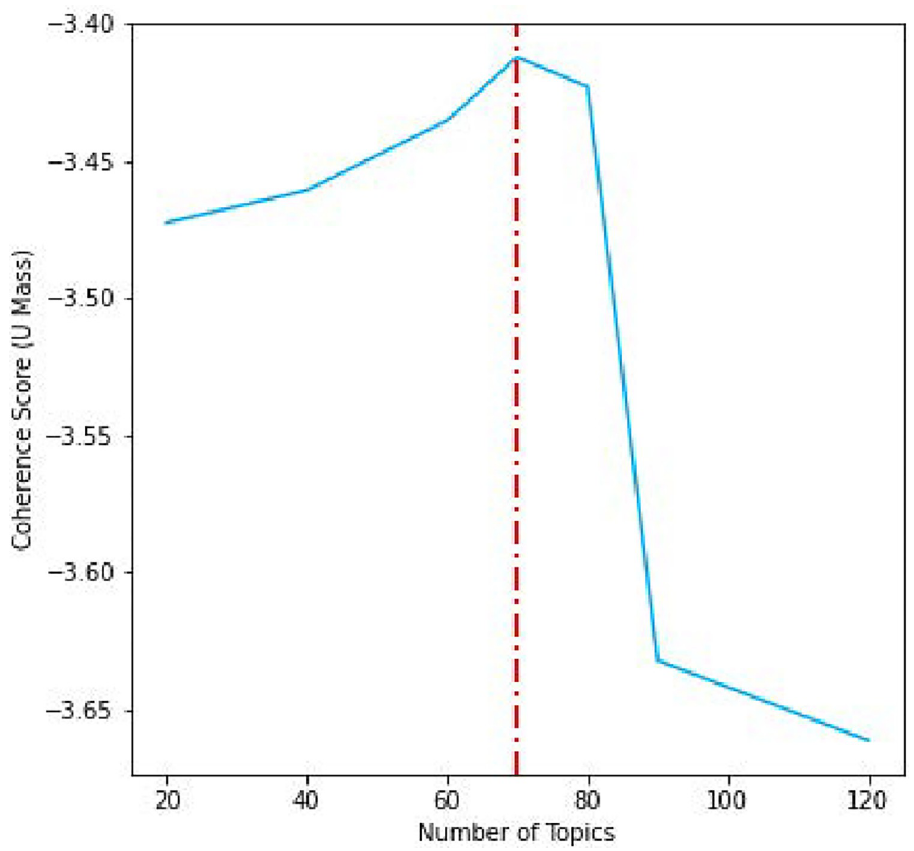
Fig 5. Static LDA coherence scores for varied numbers of topics.